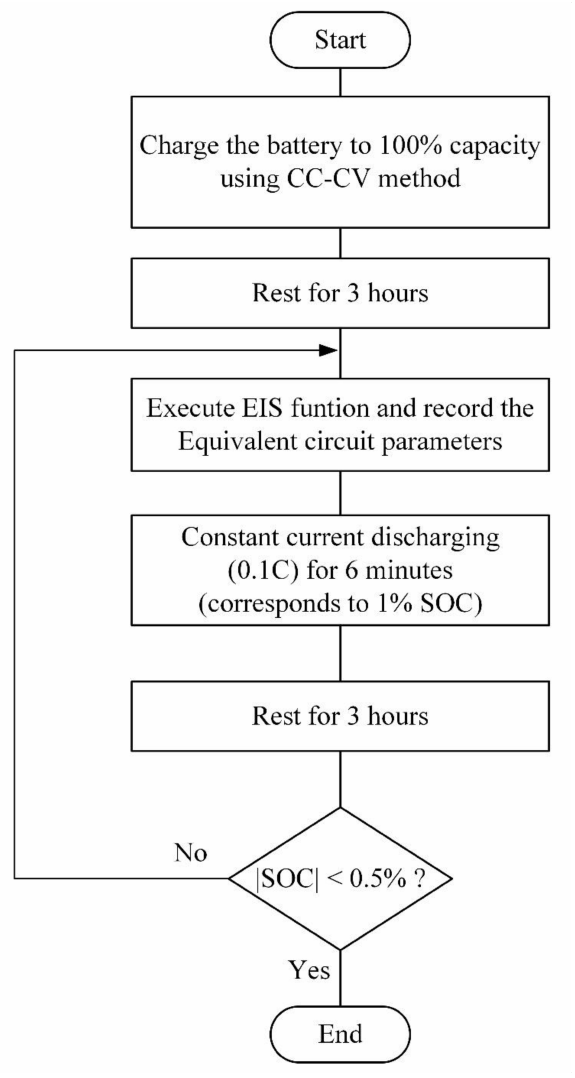
Figure 3. Flowchart of the ACZ